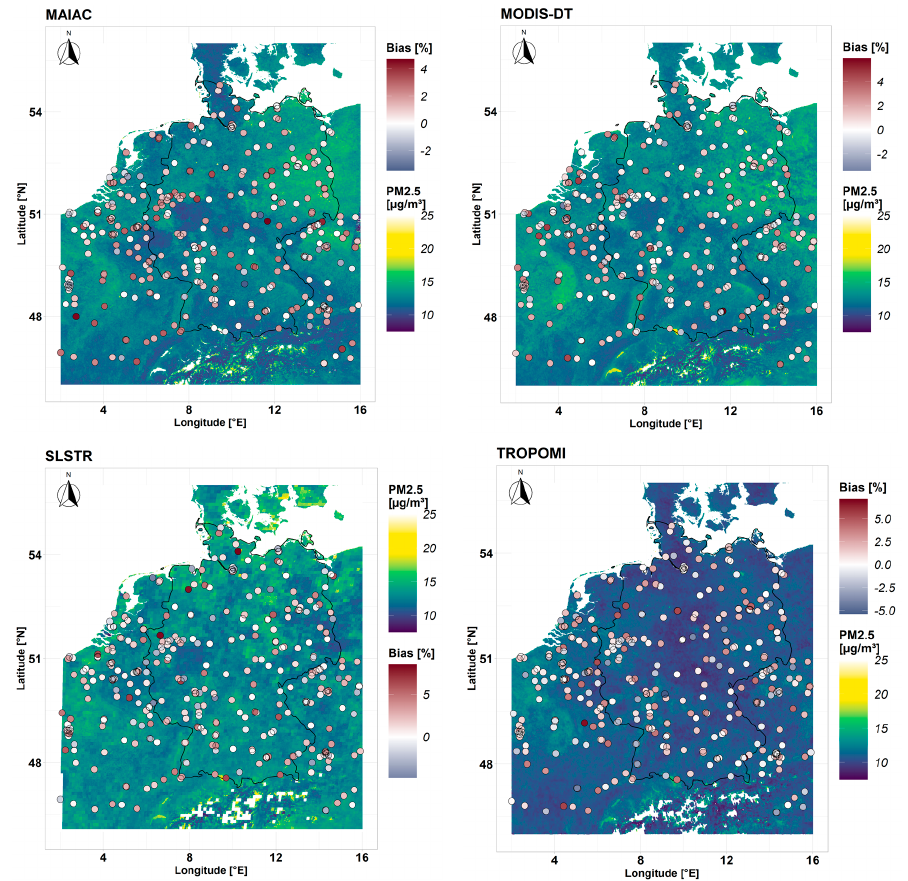
Figure 2. Annual mean PM2.5 predictions ( µ g/m 3 ) for 2018 from the different RF-models MAIAC, MODIS-DT, SLSTR and TROPOMI. The circles depict the bias in % as the difference between the annual mean predictions and observations at monitoring sites.